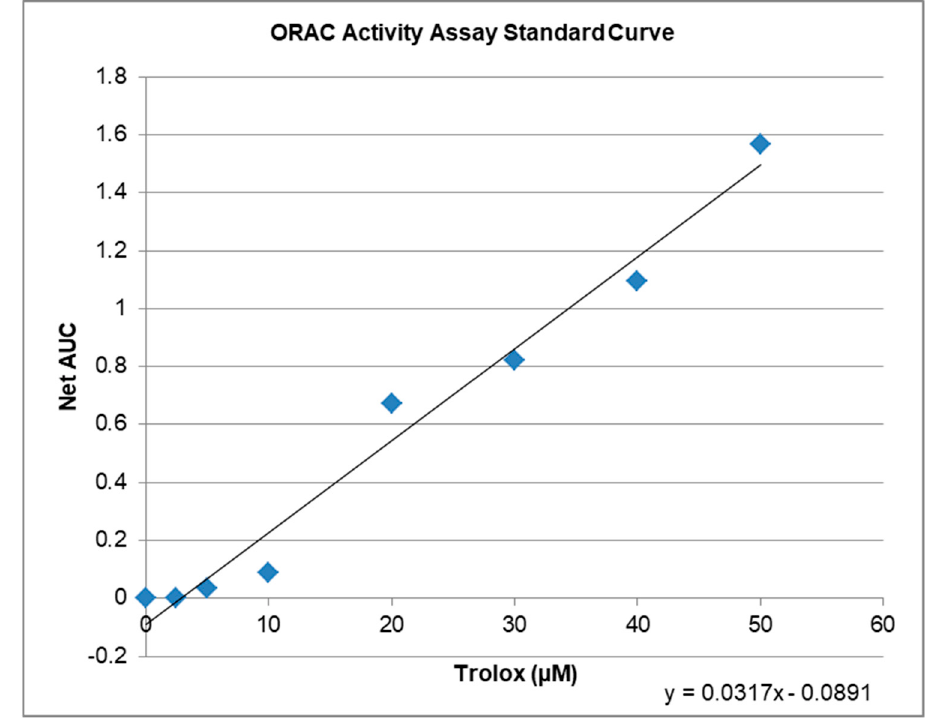
Figure 3. ORAC activity assay standard curve with regression equation y = 0.0317x − 0.0891, that was used to calculate the µM Trolox™ Equivalents (TE) of the tested compounds. Table 1. ORAC activity assay data for KIT C and KIT H. Raw values and Trolox™ Equivalents in µM.